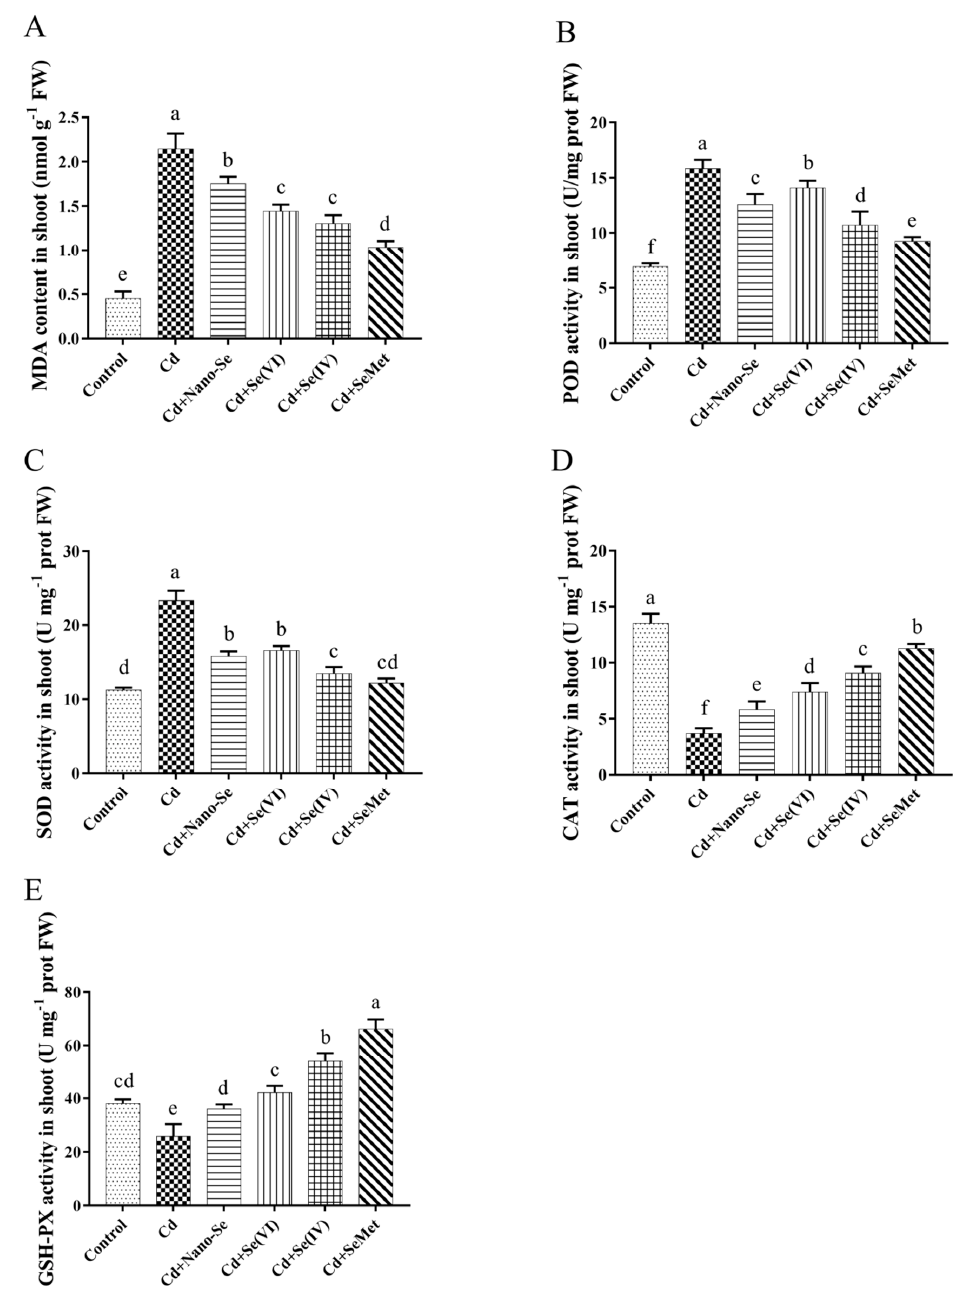
Figure 5. E ff ects of di ff erent Se forms on malondialdehyde (MDA) content ( A ) and peroxidase (POD) ( B ), superoxide dismutase (SOD) ( C ), catalase (CAT) ( D ), and glutathione peroxidase (GSH-Px) ( E ) activities of rice seedlings in the presence of Cd. Data points and error bars represent mean values ± SD ( n = 3). The di ff erent letters indicate statistically significant di ff erences between the treatments at p <